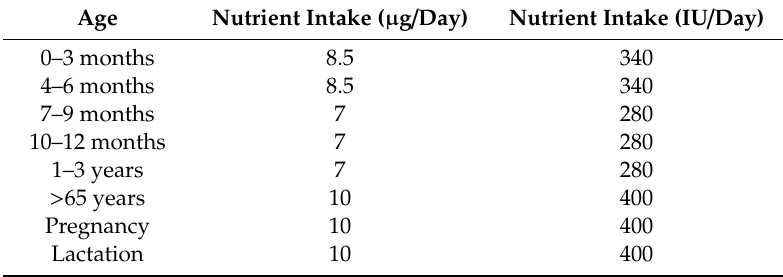
Table 1. Dietary recommendations for vitamin D.